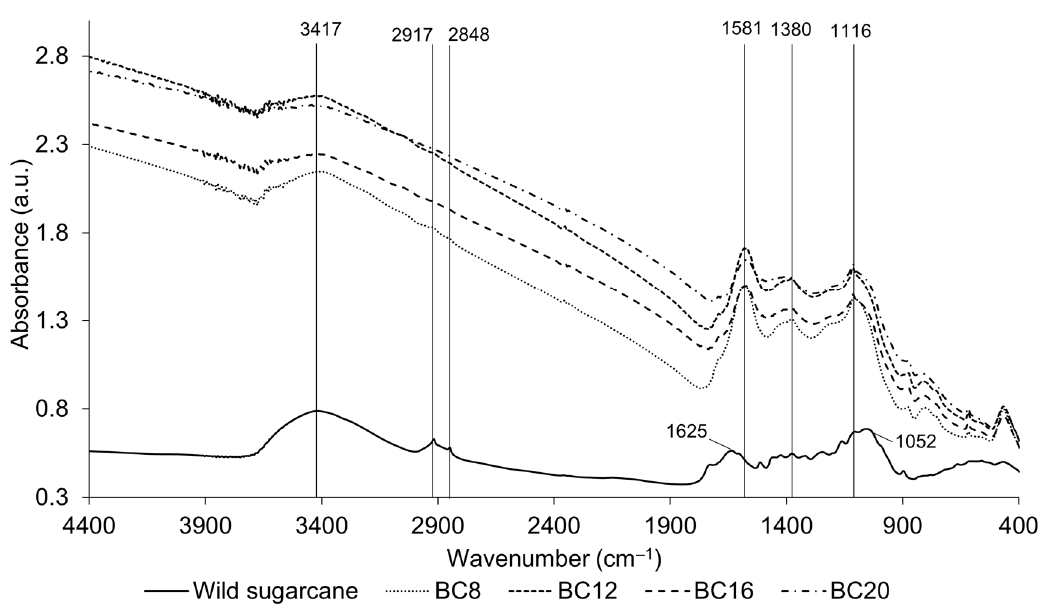
Figure 6. Fourier transformed infrared spectroscopy for wild sugarcane and wild sugarcane biochars produced at different airflow rates. BC stands for biochar, and the number represents the airflow rate used for gasification, e.g., BC8—8 L/min.